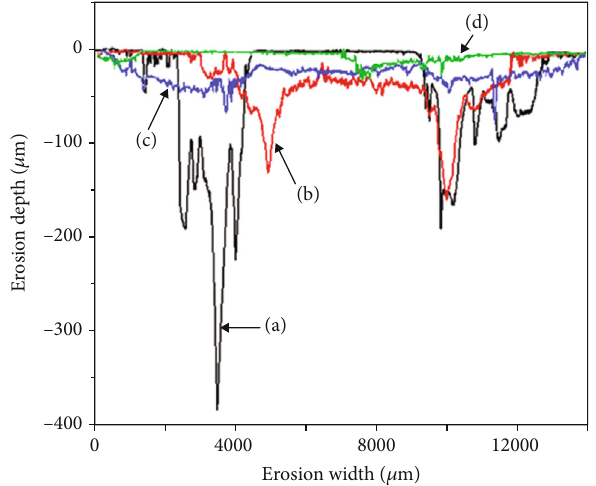
Figure 9: Surface pro fi les by PD for epoxy nanocomposites with di ff erent alkyl-modi fi ed nanosilica contents: (a) 0phr, (b) 1phr, (c) 3phr, and (d)